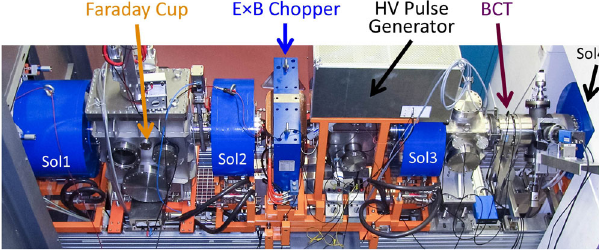
FIG. 10. FRANZ LEBT section, including the E × B chopper.